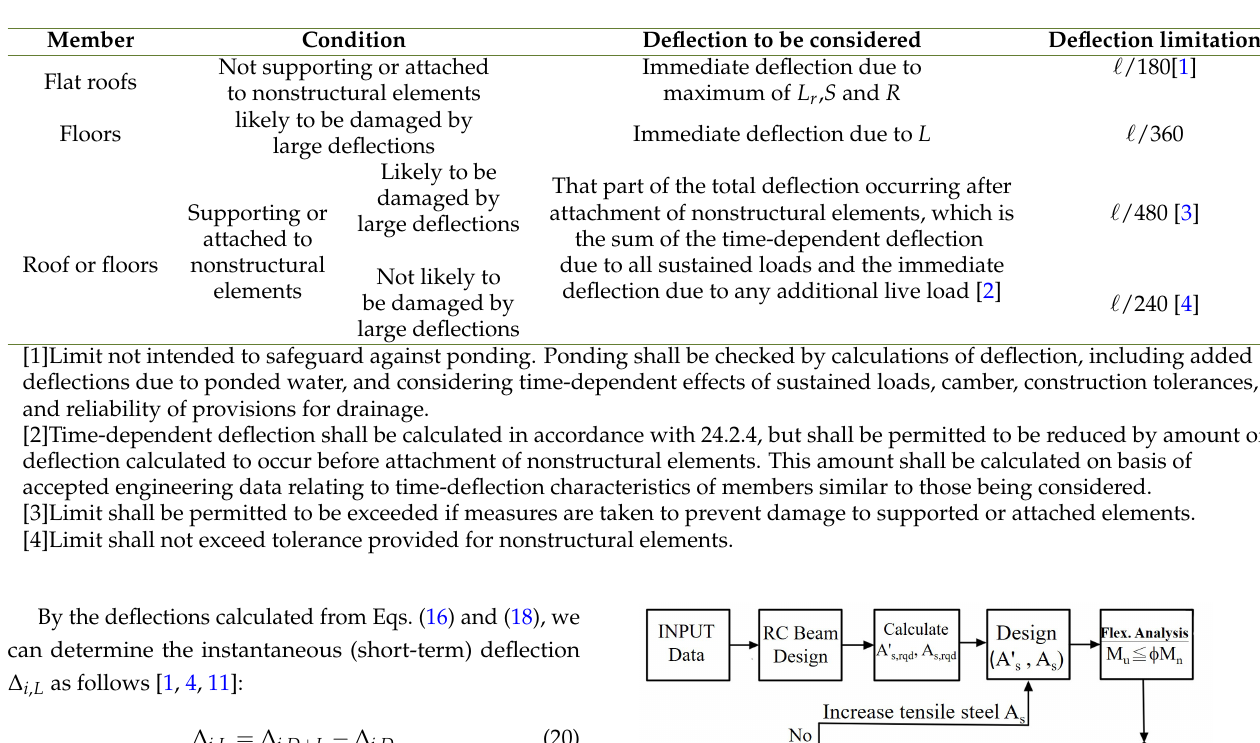
Table 2. Maximum permissible calculated deflections [1]